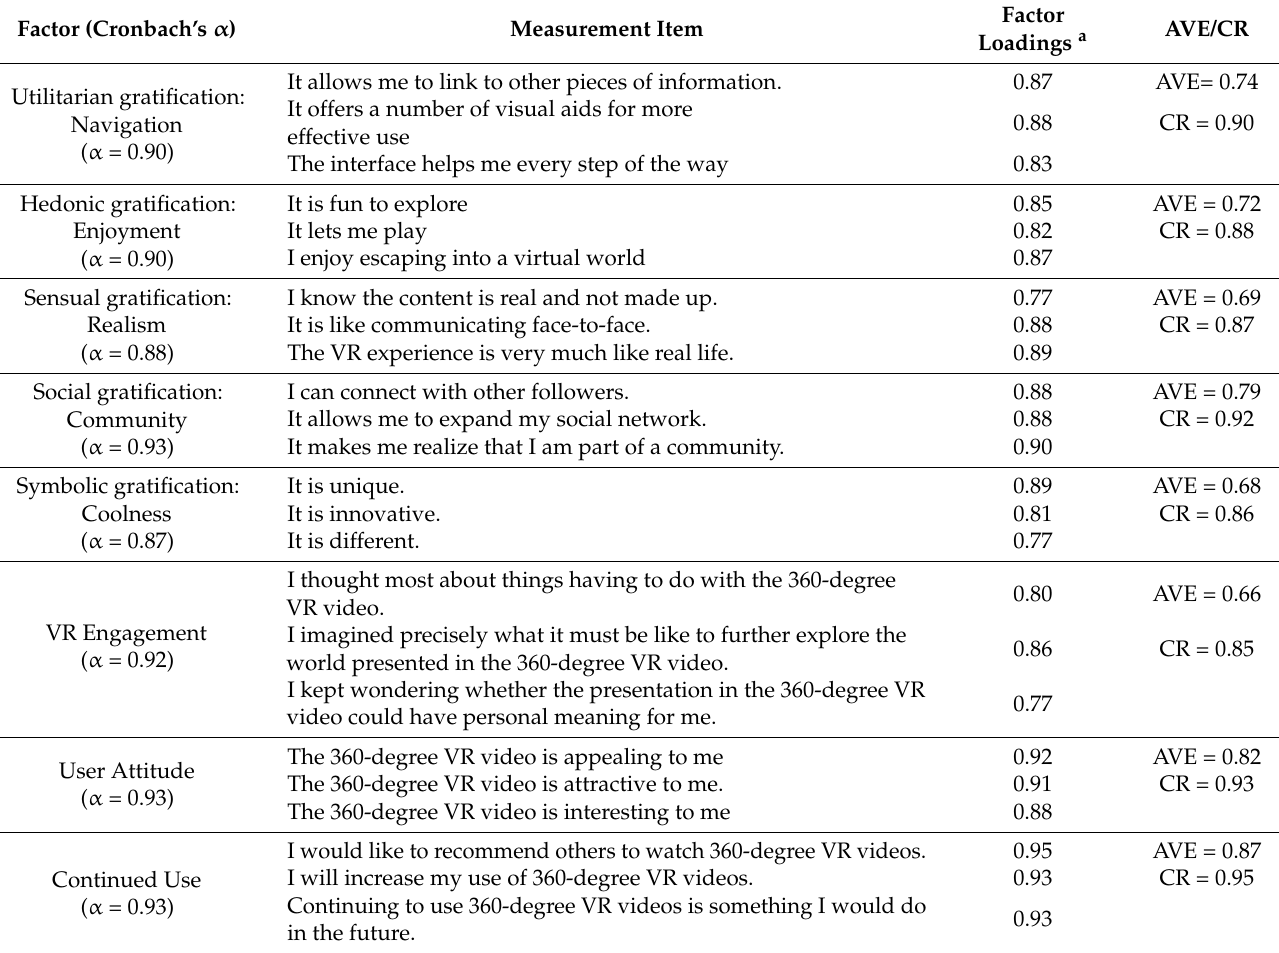
Table 3. Results of the measurement